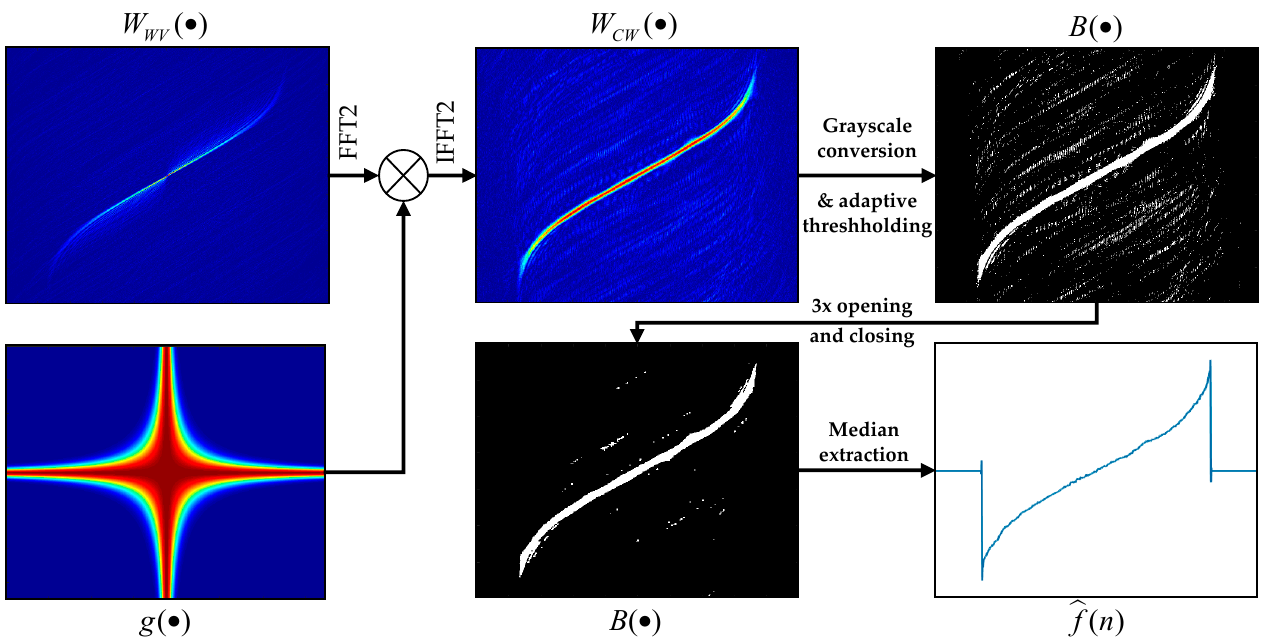
Figure 5. Illustration of the morphological instantaneous frequency (IF) estimator based on the Choi–Williams distribution (CWD) image, for some arbitrary nonlinear-frequency modulated signal (NLFM) immersed in noise with signal-to-noise ratio (SNR) of 0 dB.